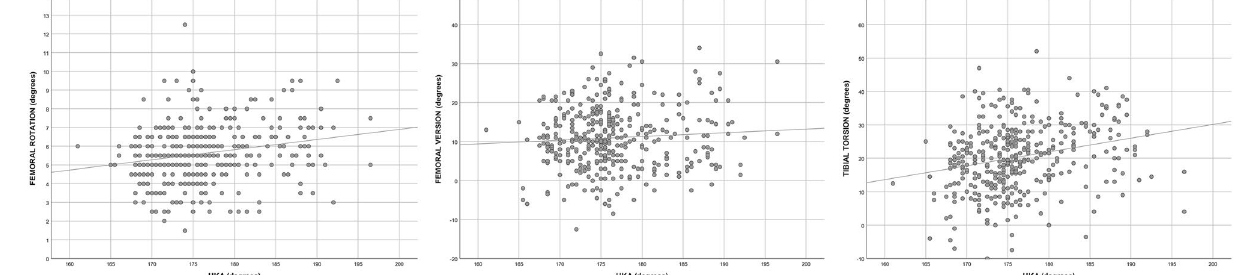
Figure 3. Scatter plots of the rotational alignment with regard to the coronal alignment of the limb. HKA, hip-knee-ankle angle. For the Femoral Version, positive values represent anteversion and negative values retroversion. For the Tibial Torsion, positive values represent external tibial torsion and negative, internal tibial torsion.